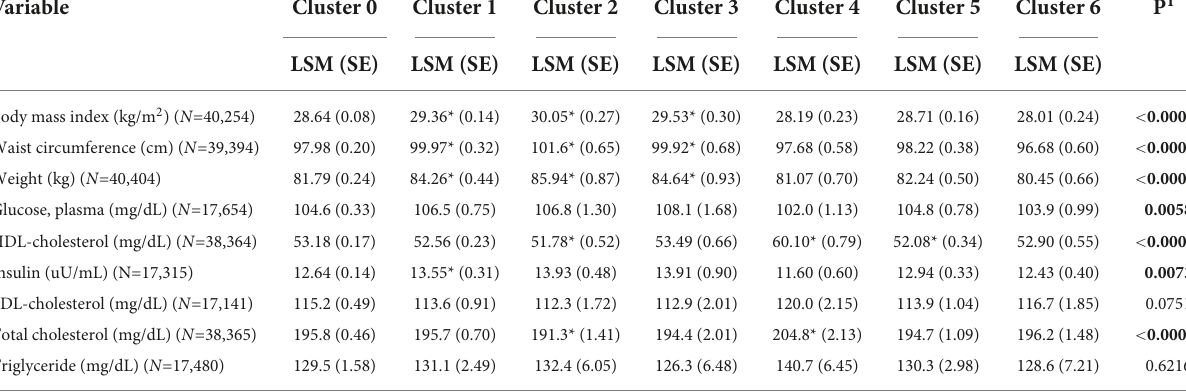
TABLE 6 Least square mean anthropometrics and biomarkers by potato cluster in American adults.